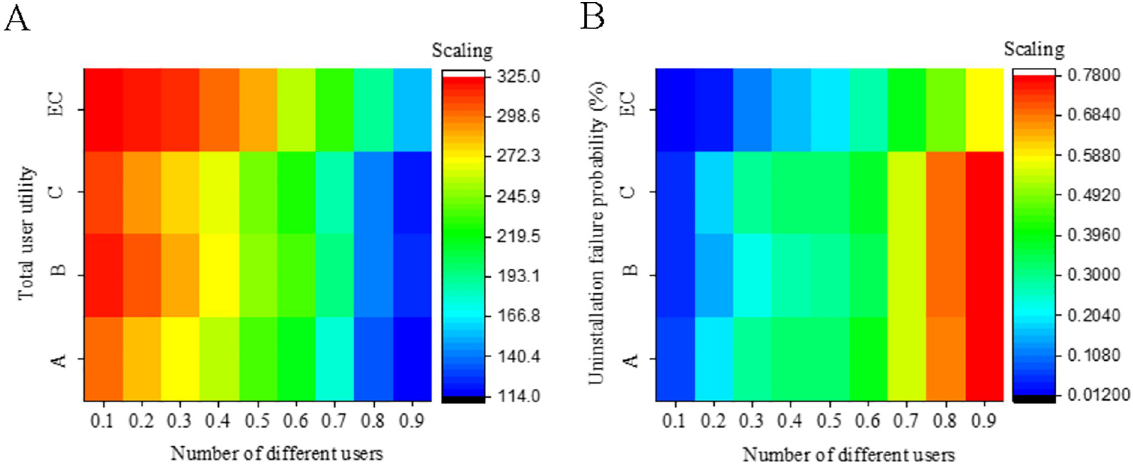
Fig 7. User utility and uninstallation failure under different number of users.